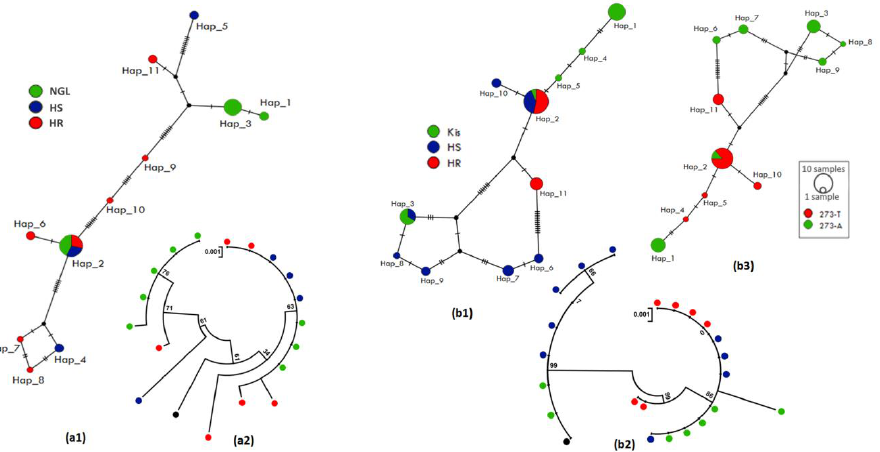
Hd = 0.58, π = 0 .0013) were found in 273 - T allele carriers (Figure 5(b3), Supplementary Table S5).